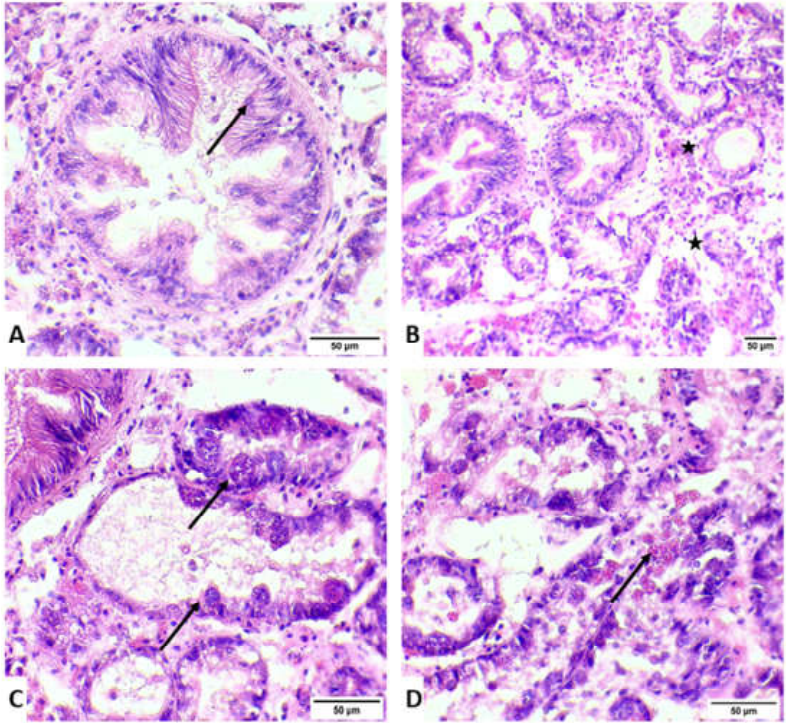
Figure 4. Histological display of Marteilia refringens life stages in digestive glands of M. galloprovin- cialis . ( A ) Histological display of a nurse cell in the digestive tubule epithelium (arrow). ( B ) Strong hemocyte infiltration of the digestive gland (star). ( C ) Sporangia life stage of M. refringens inside the digestive gland epithelium (arrows). ( D ) Sporangiospore development in the digestive gland (arrow). H&E × 40, × 20, × 40, × 40.